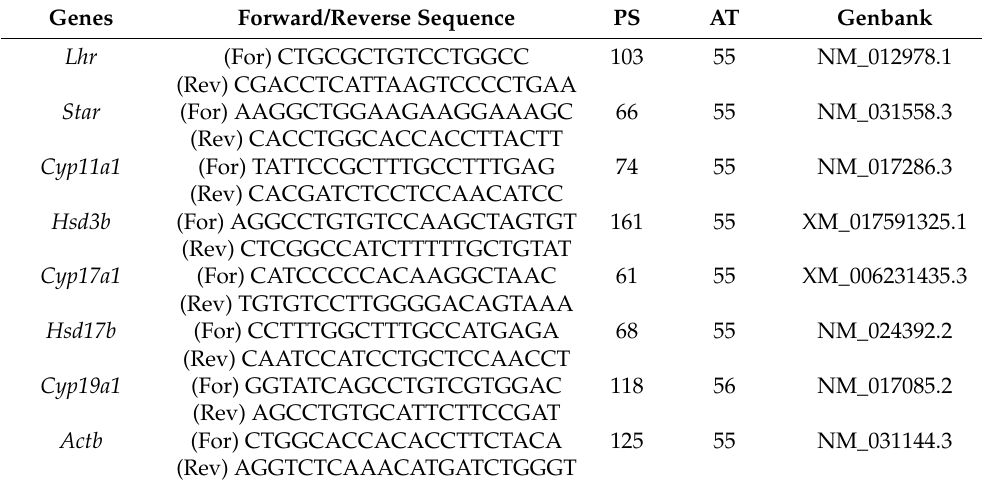
Table 8. The primers for the study of target and reference genes using real-time PCR